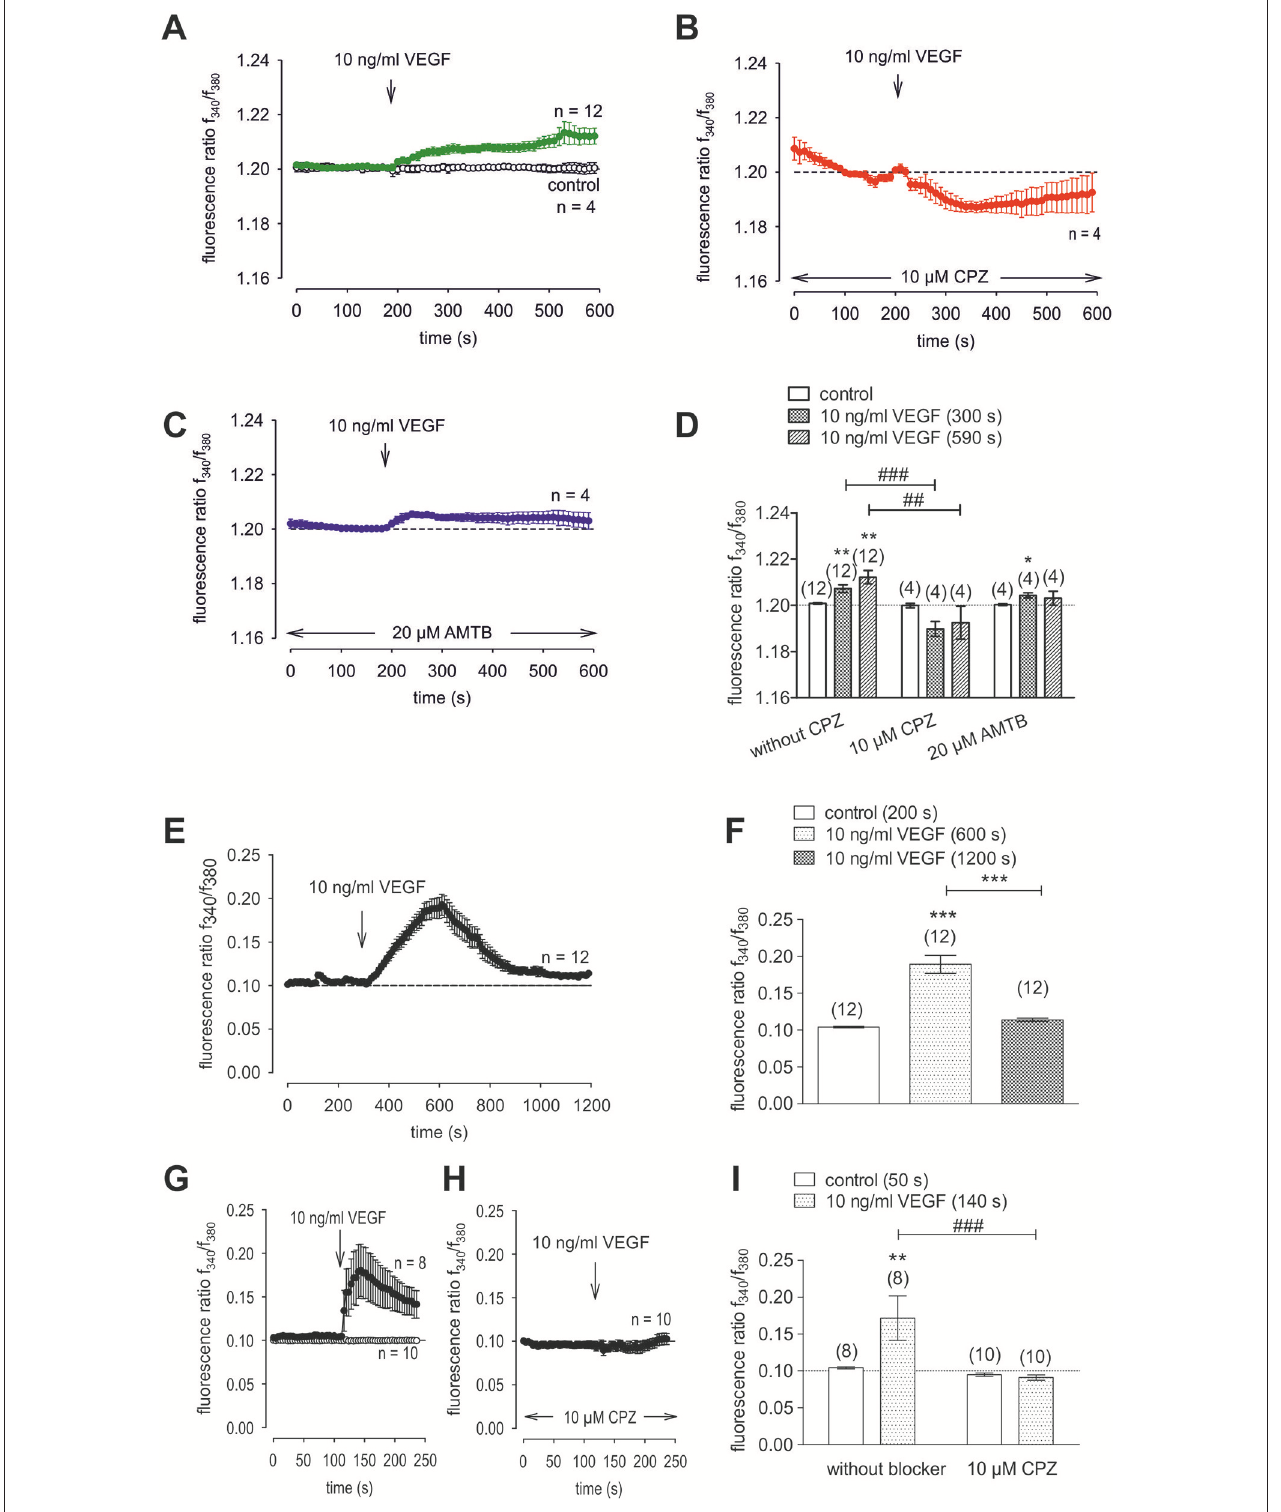
FIGURE 10 | VEGF elicits increases in Ca 2 + entry through TRPV1 activation in HCK. The pharmacological changes were carried out at the time points indicated by arrows. Data are mean ± SEM of 4-12 experiments. (A) VEGF (10ng/ml) induced an irreversible Ca 2 + influx ( n = 12) whereas non-treated control cells showed a constant Ca 2 + baseline ( n = 4). (B,C) Same experiments as shown in (A) , but in the presence of CPZ (B) and AMTB (C). Whereas, CPZ (10 µ M) clearly suppressed